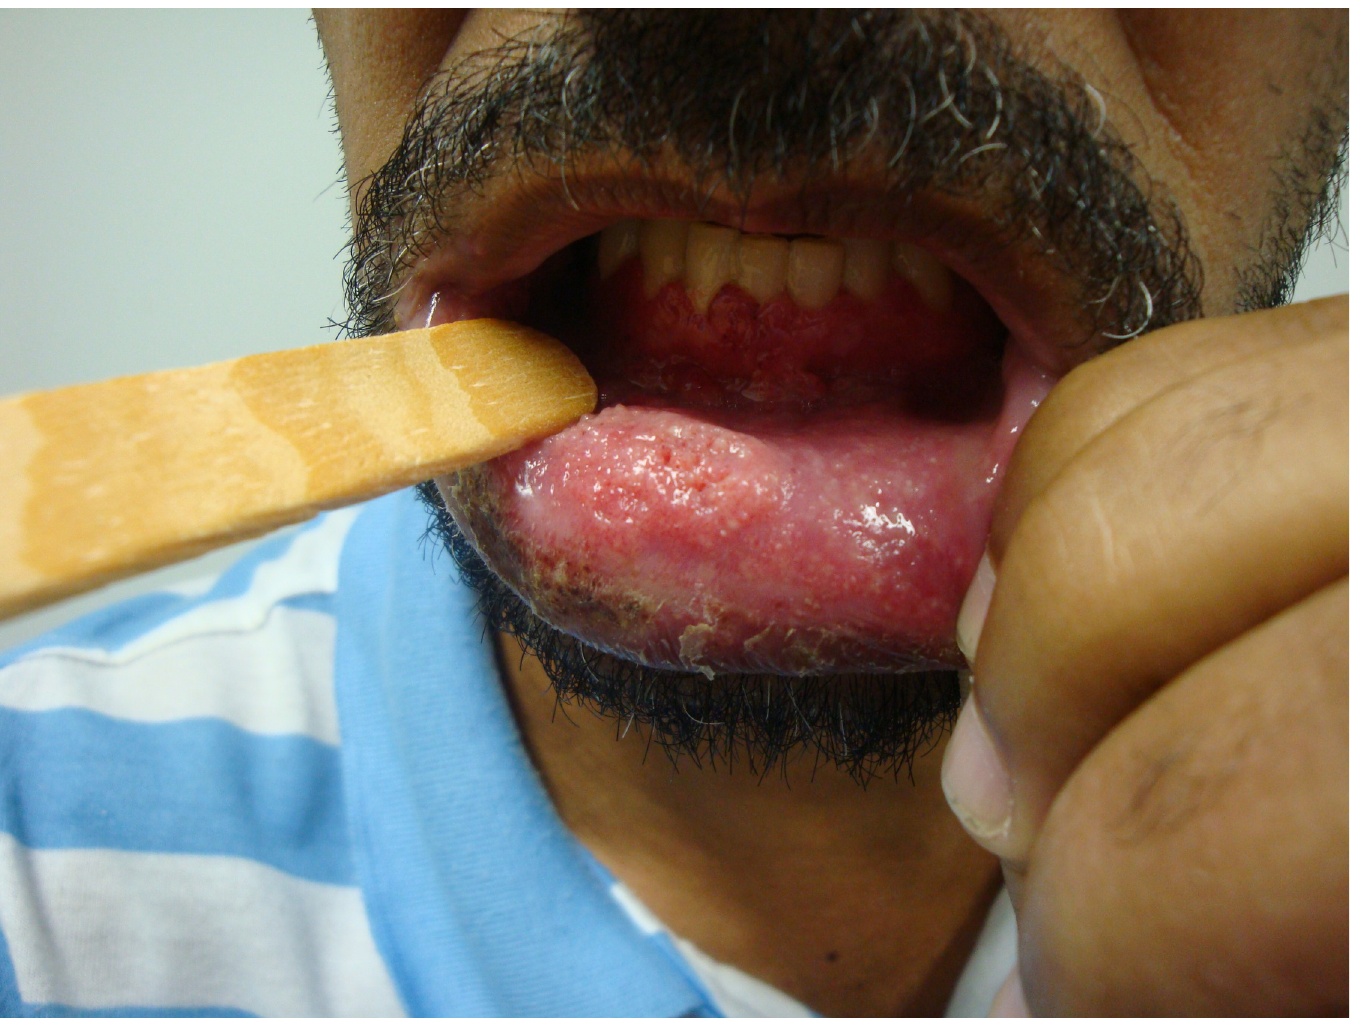
Fig 4. Ulcero-vegetative lesion on the lower lip due to hematogenous dissemination of Paracoccidioides sp. in a patient living with HIV/AIDS. Patient from group B, 45 years old, with recurrent oral lesion after two years of an irregular